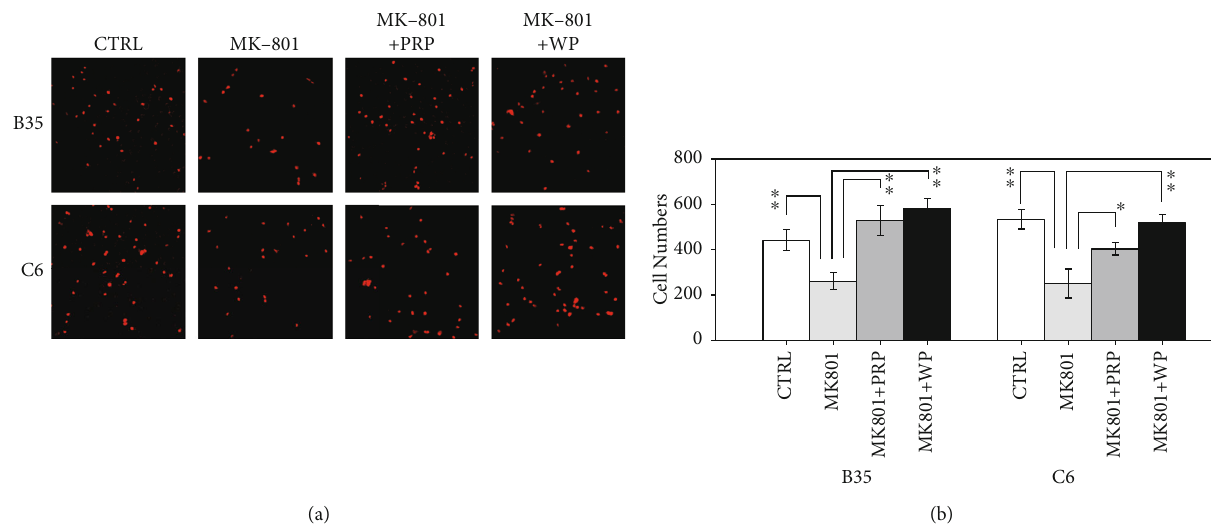
Figure 4: E ff ects of MK-801, PRP, and WP on B35 and C6 cell migration. (a) Cell mobility of B35 and C6 cells was analyzed. The migrated cells were stained with propidium iodide, and then the number of cells on the membrane was counted. (b) The result in the bar chart was made from cell counts of three di ff erent drug-treated cell batches and analyzed using Student ’ s t -test ( ∗ p value < 0.05; ∗∗ p value <